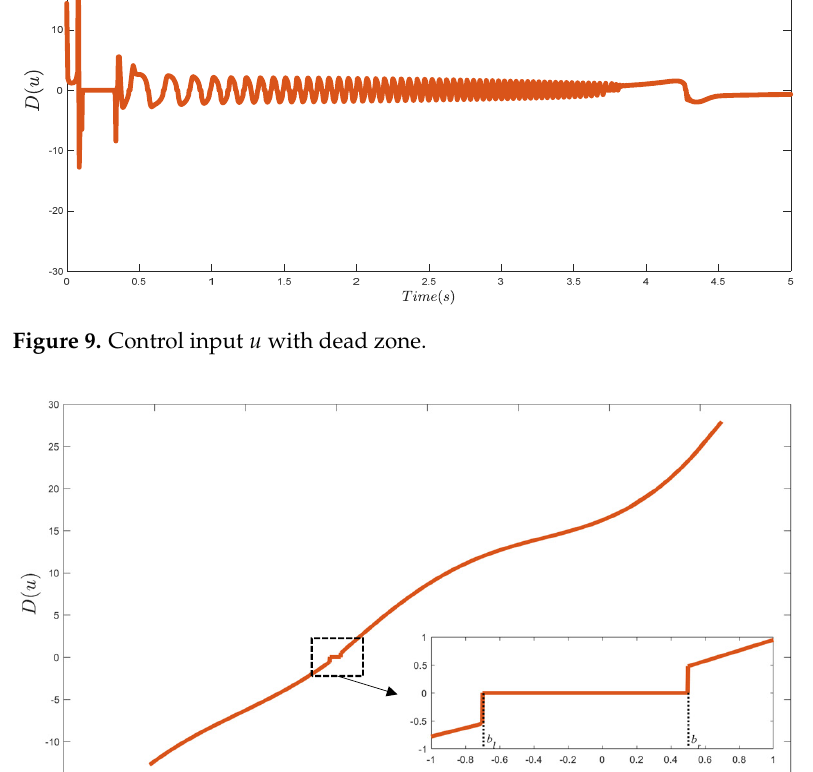
Figure 10. Control input u with dead zone and the control input.